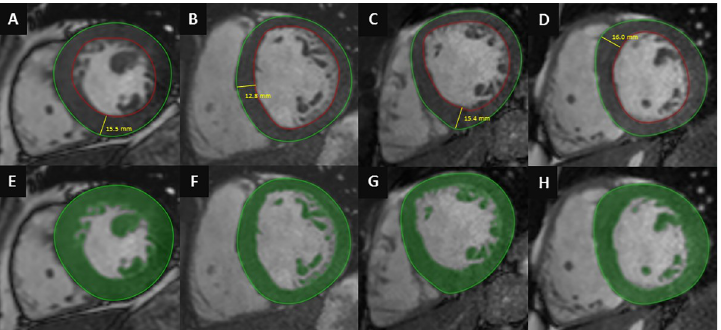
Fig 1. Conventional quantification (A,B,C,D) and threshold-based quantification method (E,F,G,H) in HCM (A,E), healthy athlete (B,F), healthy athlete with EDWT in the grey zone of hypertrophy (C,G) and athlete with HCM